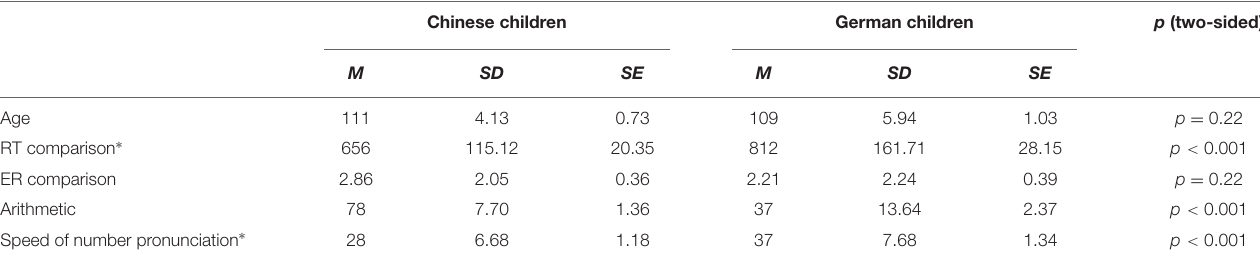
TABLE 2 | Comparison of Chinese and German children (paired-sample t -tests/Kolmogorov–Smirnov- Z tests) with respect to age (in month), reaction times (in ms) and errors (in %) in the symbolic numerical magnitude comparison task (RT comparison, ER comparison), arithmetic skills, and speed of number pronunciation (in